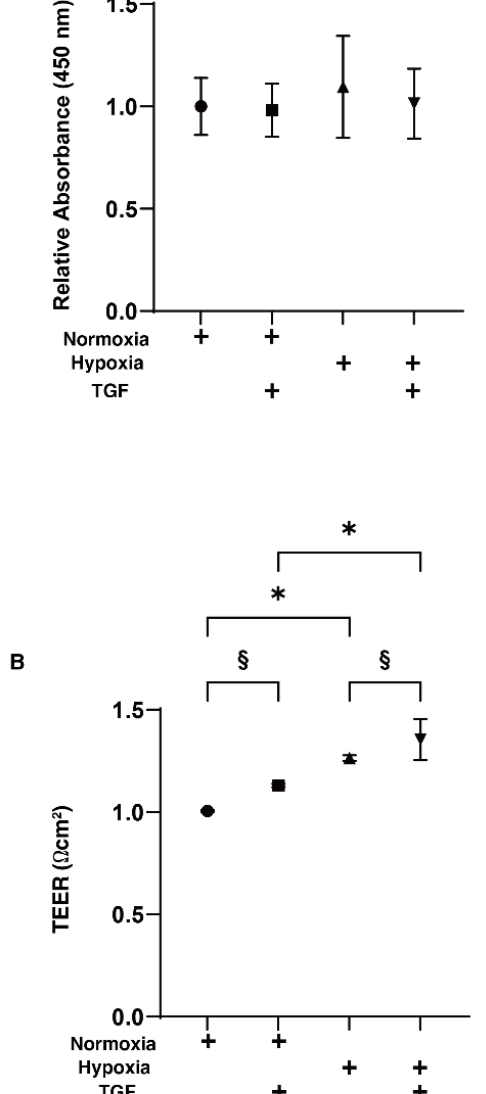
Figure 1. Effects of TGF- β 2 on cell viability and transendothelial electrical resistance (TEER) measure- Figure 1. Effects of TGF- β2 on cell viability and transendothelial electrical resistance (TEER) meas- ments of 2D HRPE monolayers under normoxia or hypoxia conditions. The 2D HRPE cell monolayers urements of 2D HRPE monolayers under normoxia or hypoxia conditions. The 2D HRPE cell mon- prepared under normoxia or hypoxia conditions were treated without (control) or with a 5 ng/mL olayers prepared under normoxia or hypoxia conditions were treated without (control) or with a 5 solution of TGF- β 2 (TGF). The 2D cultures of HRPE monolayers at Day 6 were subjected to ( A ) cell ng/mL solution of TGF- β2 (TGF). The 2D cultures of HRPE monolayers at Day 6 were subjected to viability by a CCK-8 kit and ( B ) barrier function analyses by electric resistance ( Ω cm 2 ) measurements ( A ) cell viability by a CCK-8 kit and ( B ) barrier function analyses by electric resistance (Ω cm 2 ) meas- using TEER, and each relative ratio against the normoxia conditions without TGF- β 2 was plotted. urements using TEER, and each relative ratio against the normoxia conditions without TGF- β2 was All experiments were performed in triplicate using fresh preparations. “+” is reagents addition. Data plotted. All experiments were performed in triplicate using fresh preparations. “+” is rea gents ad- are presented as the arithmetic mean ± the standard error of the mean (SEM). * p < 0.05 normoxia vs. dition. Data are presented as the arithmetic mean ± the standard error of the mean (SEM). * p < 0.05 normoxia vs. hypoxia, § p < 0 .05 control vs. TGF (ANOVA followed by a Tukey’s multiple compar- hypoxia, § p < 0.05 control vs. TGF (ANOVA followed by a Tukey’s multiple comparison ison test).